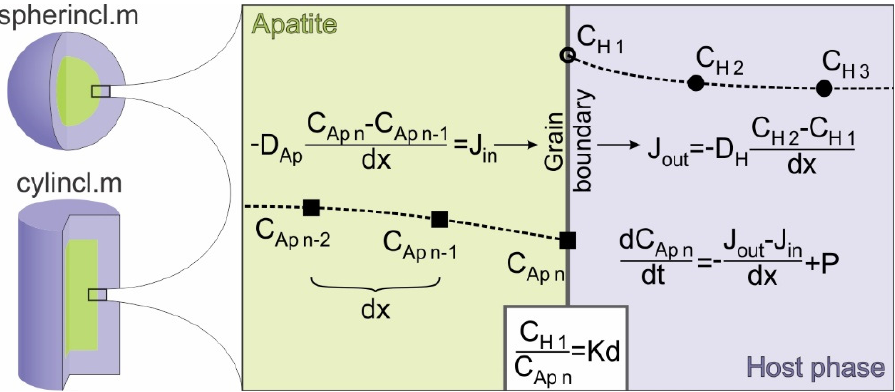
Figure 1. A graphical explanation for the chosen approach to simulate diffusive loss of radiogenic Pb from apatite inclusions hosted by other minerals. The left side shows a composite sphere modelled by spherincl.m and a composite finite cylinder modelled by cylincl.m. The right side provides a simplified description of how Pb diffusion across the apatite-host mineral interface was modelled. Black squares indicate the final three nodes in apatite, while circles show the first three nodes in the host mineral. C: concentration; dx: distance between the nodes; dt: duration of a time step; D: diffusion coefficient; J: diffusive flux; P: production by radioactive decay; Kd: partition coefficient; subscripts Ap and H designate apatite and the host mineral, respectively.